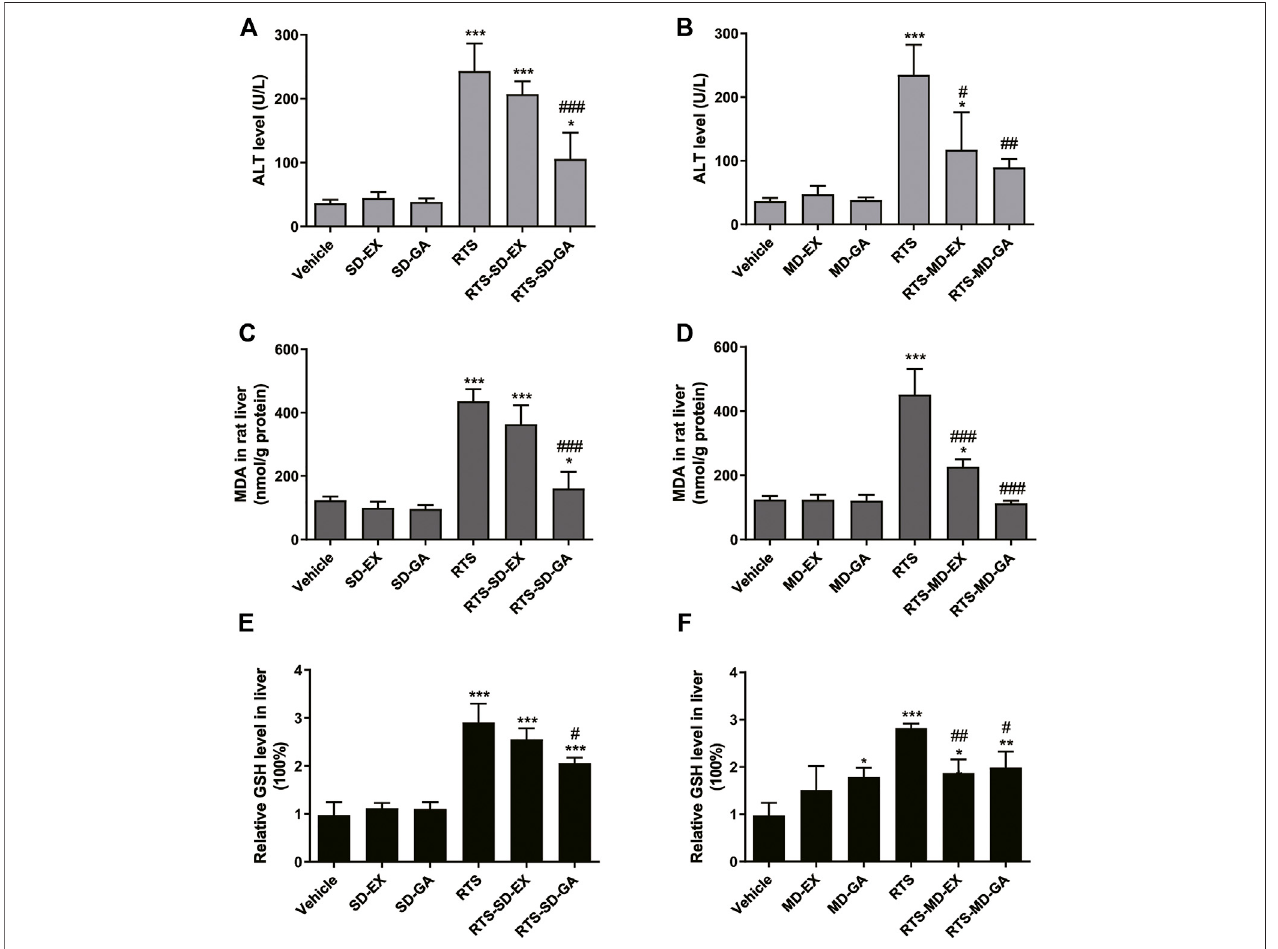
FIGURE 2 | Single-dose (SD) and multiple-dose (MD) of EX or GA protected against RTS-induced liver injury. The activity/levels of serum ALT (A,B) , hepatic MDA (C,D) , and GSH (E,F) were measured in each group. ALT, alanine aminotransferase; MDA, malondialdehyde; GSH, glutathione. * p < 0.05, ** p < 0.01, and *** p < 0.001 versus vehicle group. # p < 0.05, ## p < 0.01, and ### p < 0.001 vs . the corresponding RTS